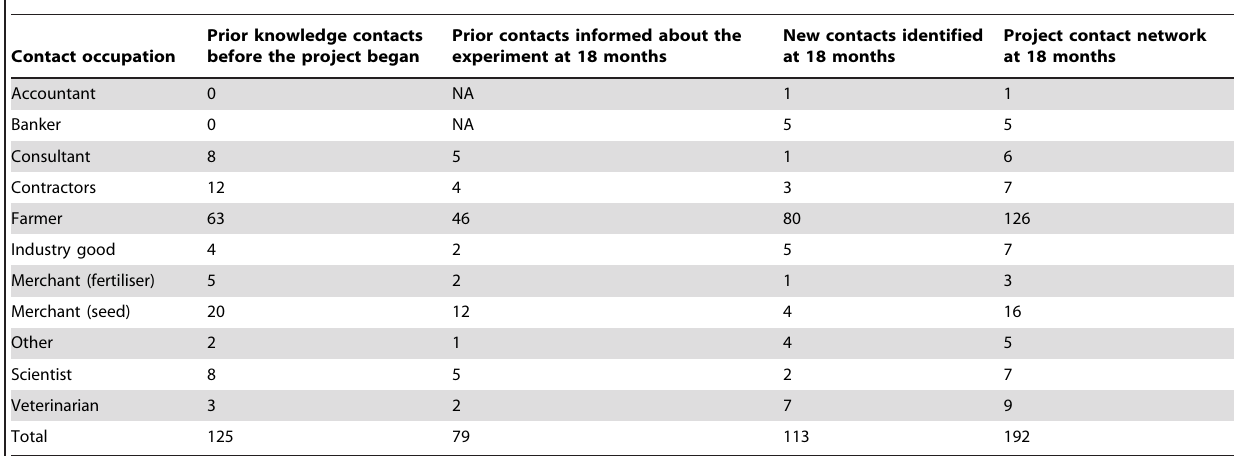
Table 2. Farmer contacts for herb pasture knowledge by project stage and occupation.